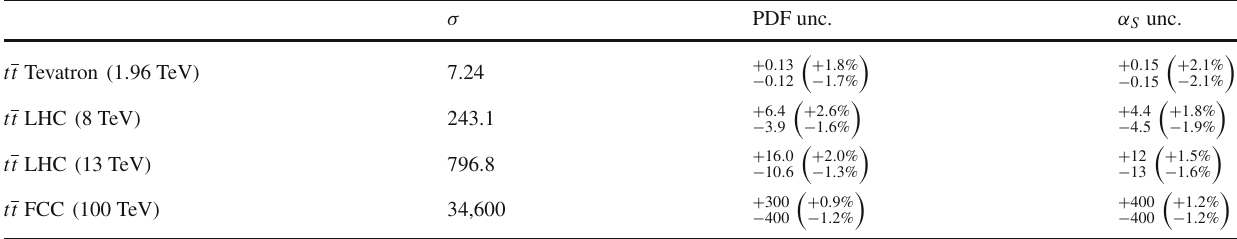
Table 3 Predictions for tt cross sections (in pb), obtained with the NNLO MSHT20 parton sets. The PDF and α S uncertainties are shown, where the α S uncertainty corresponds to a variation of ± 0 . 001 around